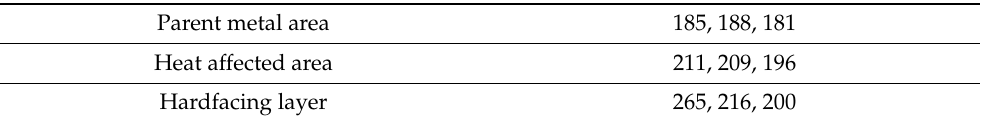
Table 6. Micro-hardness in different zones of weld overlay.